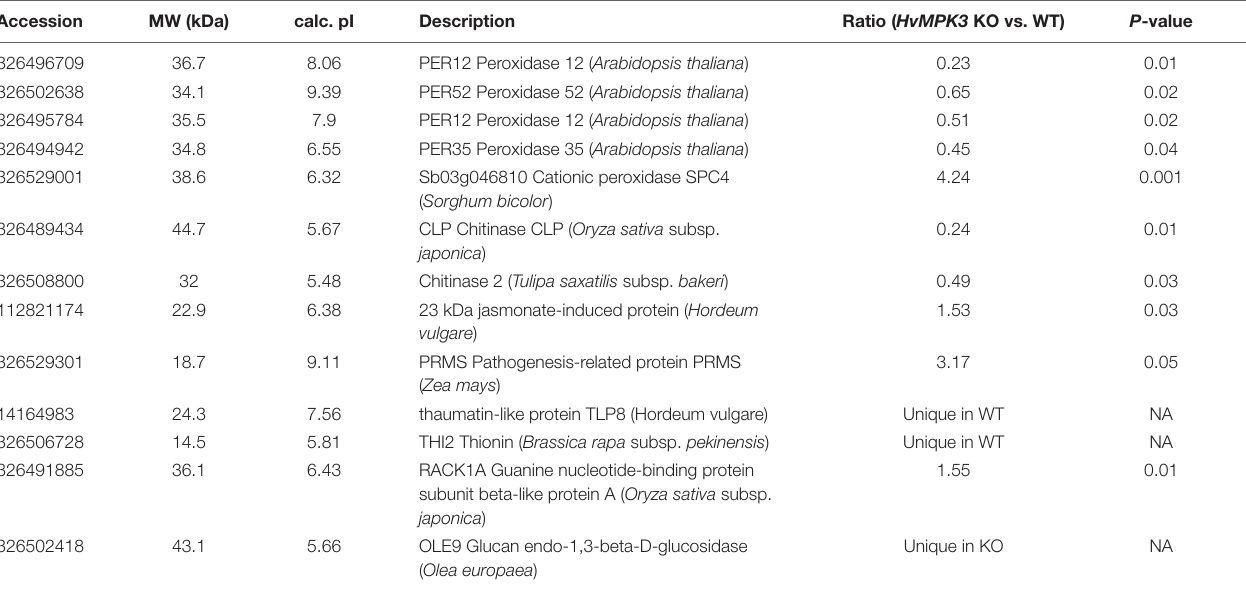
FIGURE 4 | Immunoblotting analysis of HSP70 abundance in barley HvMPK3 KO lines. (A) Immunoblot showing the abundance of HSP70 in roots of wild type (WT) as well as two independent HvMPK3 KO lines (KO-B and KO-C). (B) Quantification of band intensities in (A) . Asterisks indicate statistically significant differences between WT and HvMPK3 KO lines; ∗ p < 0.05, Student’s t -test. Uncropped, full original image of the immunoblot is documented in Supplementary Figure 8 . TABLE 1 | Differentially abundant defense related proteins found in HvMPK3 KO mutant as compared to wild